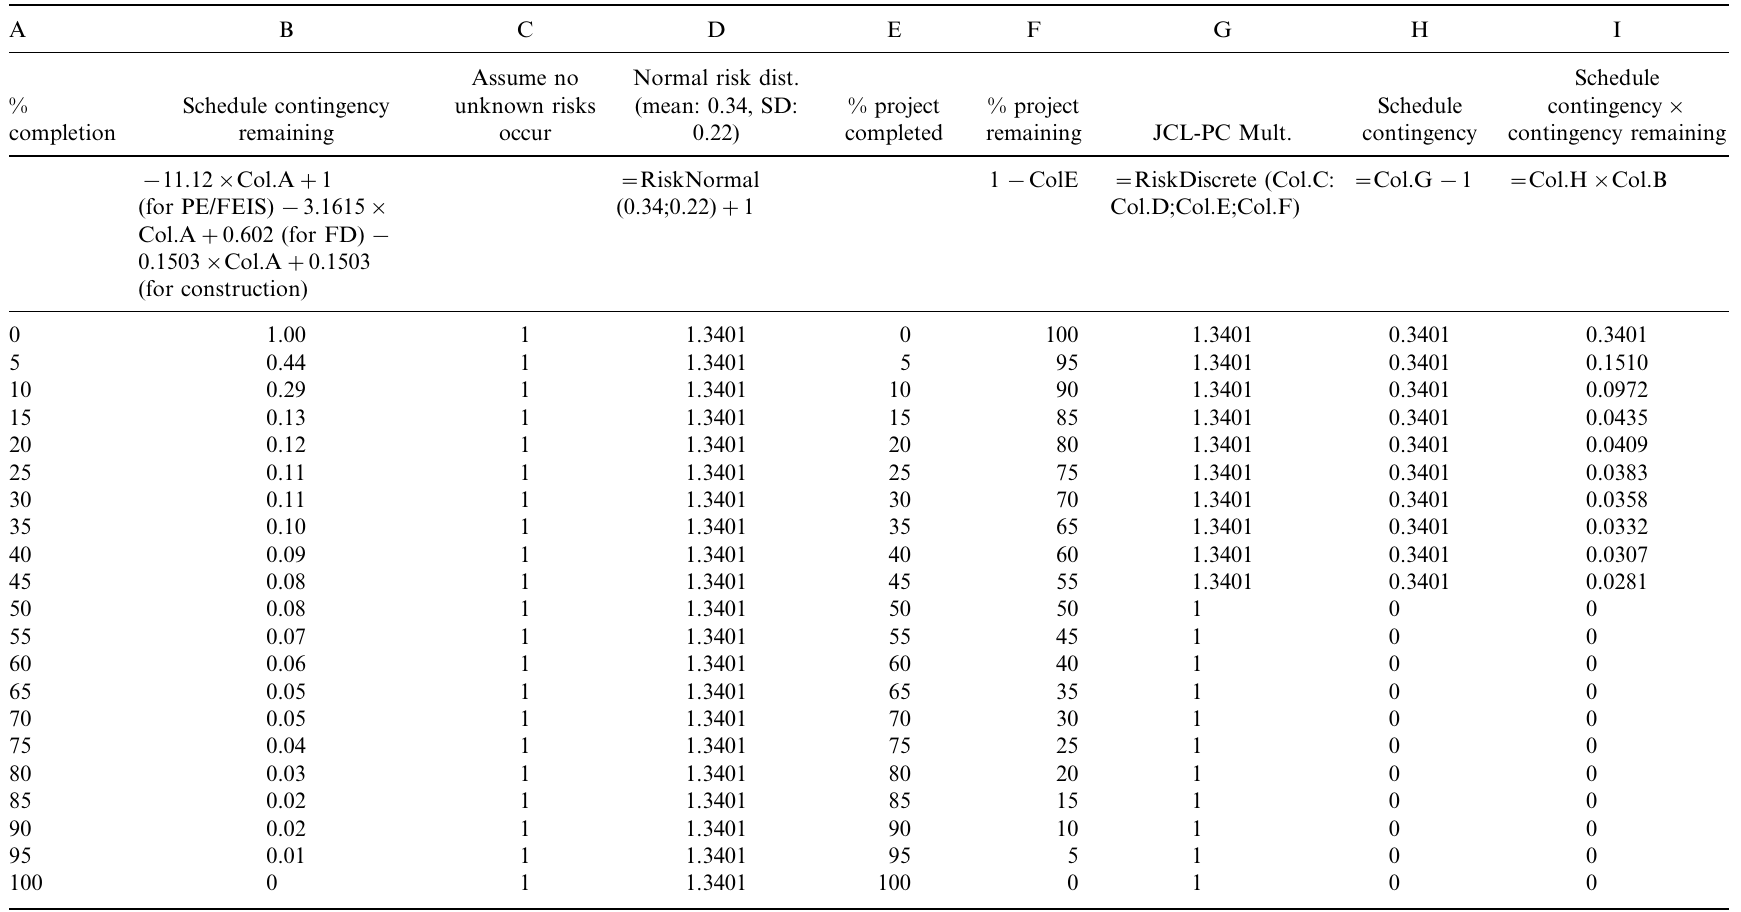
Table 4. JCL-PC notations used for simulation in the